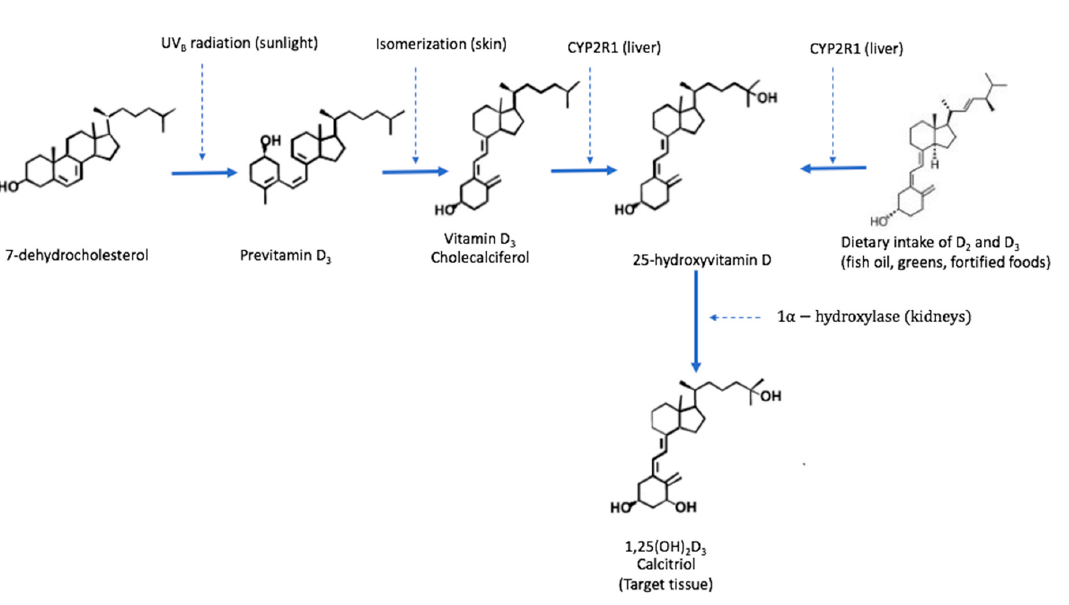
Figure 2. The metabolism of vitamin D in humans; modified from [46].